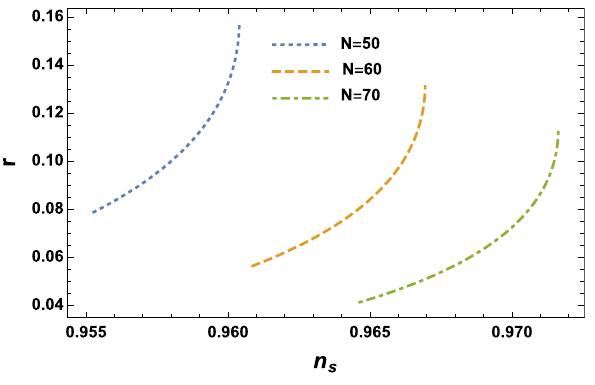
Fig. 2 n s vs r for the potential (4.27) with non-minimal kinetic cou- pling ( η = 0 , β (cid:12)= 0) for f in the interval 10 − 3 M p ≤ f ≤ 10 − 2 M p , β = 2 × 10 7 and N = 50 , 60 , 70. for N between 60 and 70 n take values in the region favored by observational data. The scale of symmetry breaking f is of the order of the GUT scale (10 16 Gev)